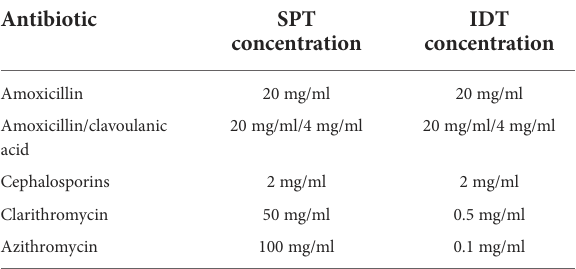
TABLE 1 Nonirritating test concentrations for antibiotics.